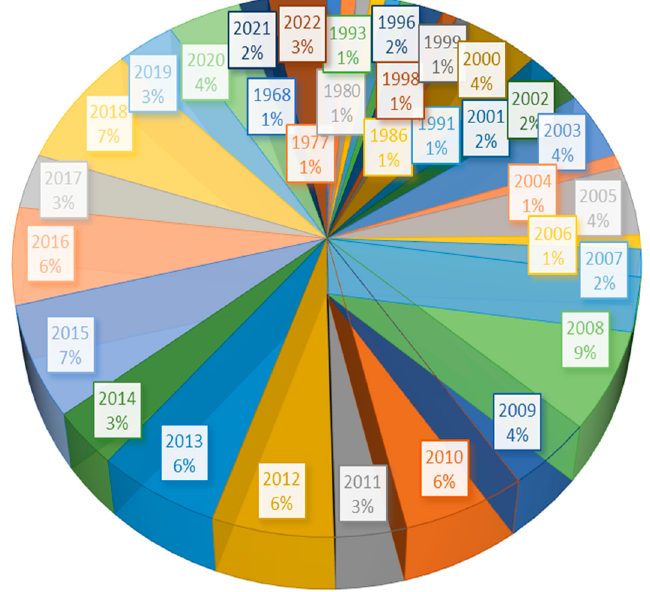
Figure 1. Pie chart illustrating the year-wise distribution of referenced papers.